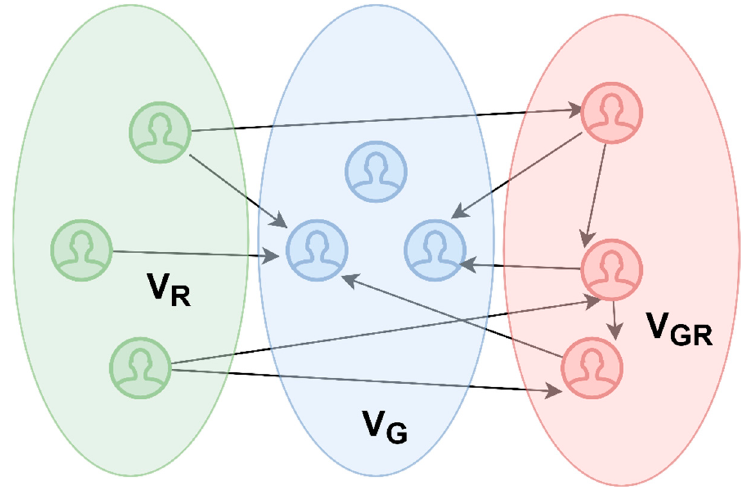
Figure 1. Visual representation of the structure of a networked discussion, by user type.